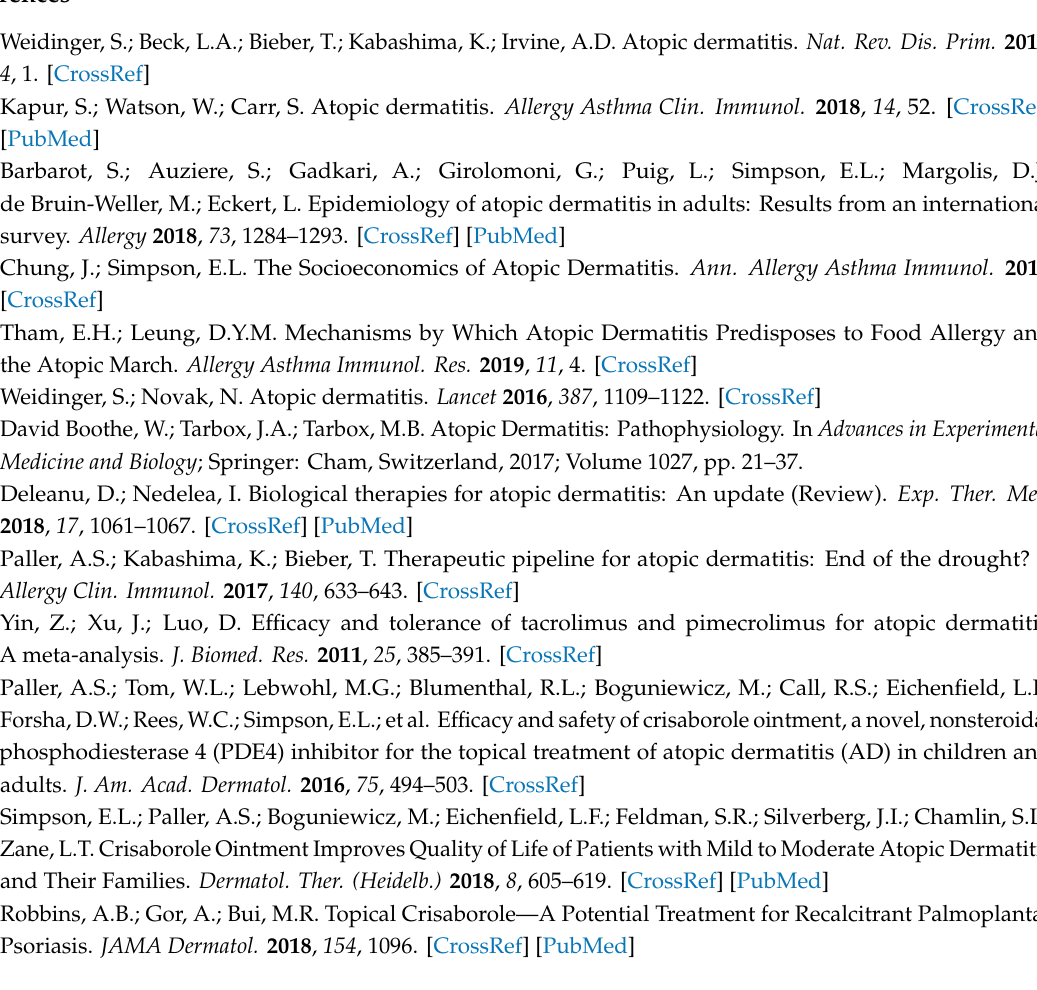
Figure S1. DSC trace of crisaborole (heating rate at 5 ◦ C / min), recorded under a flow of dry nitrogen (100 mL / min). Figure S2. Polarized-light microscopy (10X) image of the prepared